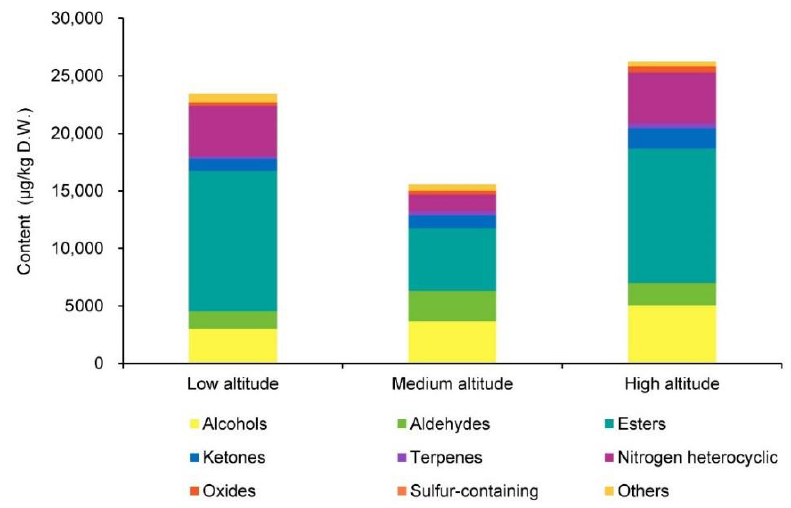
Figure 2. Categories of aroma compounds and total aroma contents in Lingtou Dancong oolong tea product from different altitudes. High altitude, medium altitude and low altitude represent the Lingtou Dancong oolong teas from high, medium and low altitude, respectively. D.W. represents dry weight.